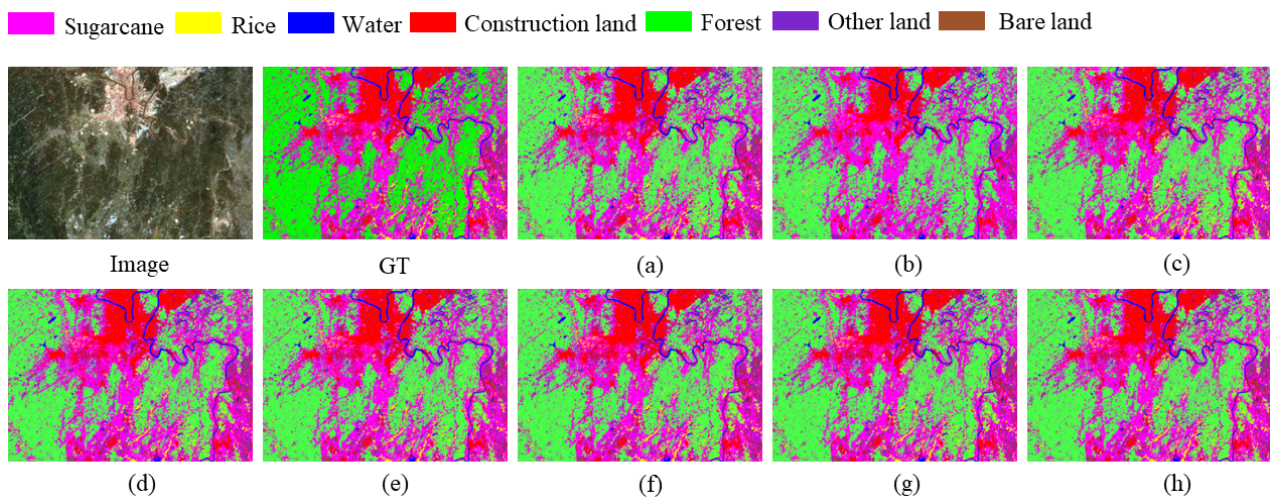
Figure 11. Semantic segmentation results on the test set in the dataset II produced by ( a ) U-Net, ( b ) U-Net++, ( c ) SAR-UNet, ( d ) Res-UNet++, ( e ) Attention-UNet, ( f ) UCTransNet, ( g ) Swin-UNet, and ( h )